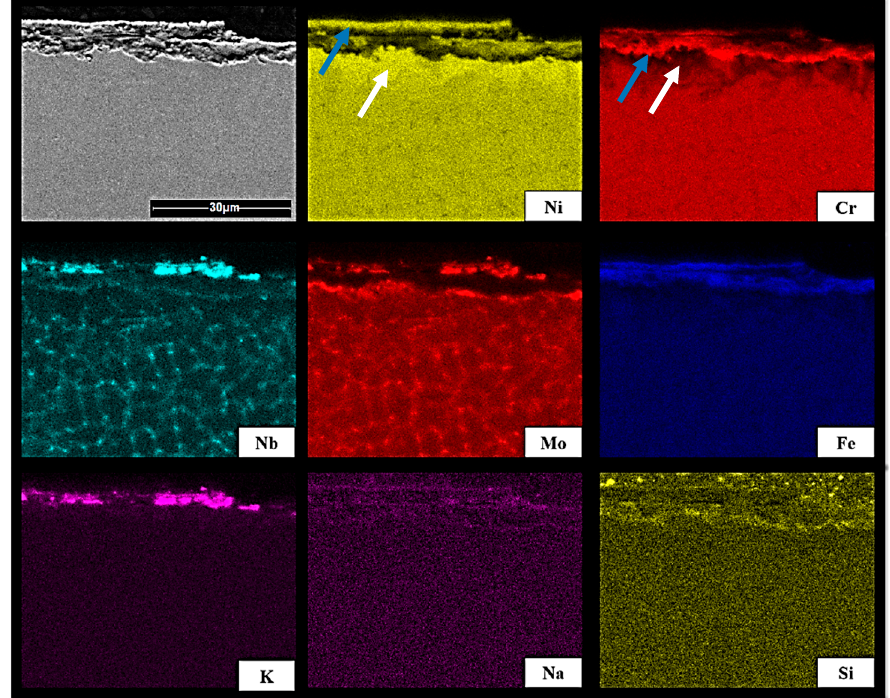
Figure 5. The SEM–EDX map of element distribution of Inconel 625 after exposure to oat straw ash (OA).